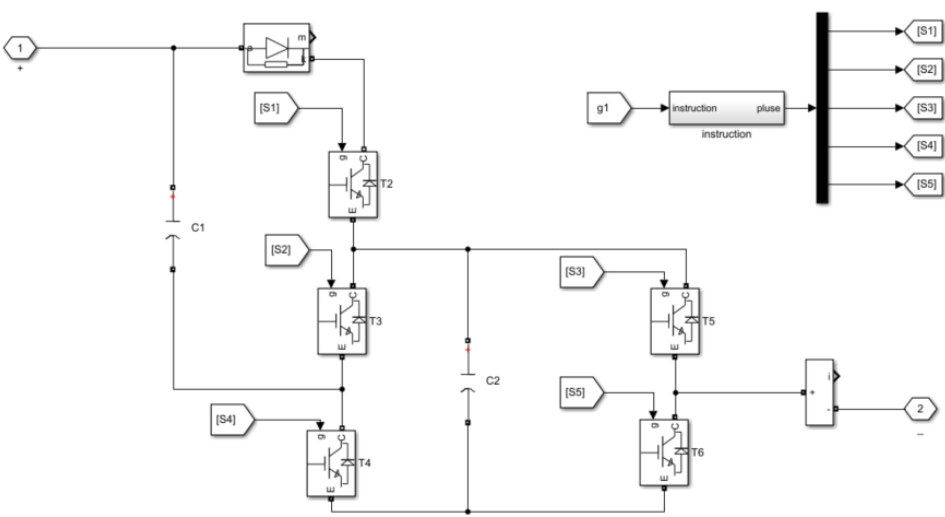
Figure A1. Simulation model of the MMC DC transmission system.